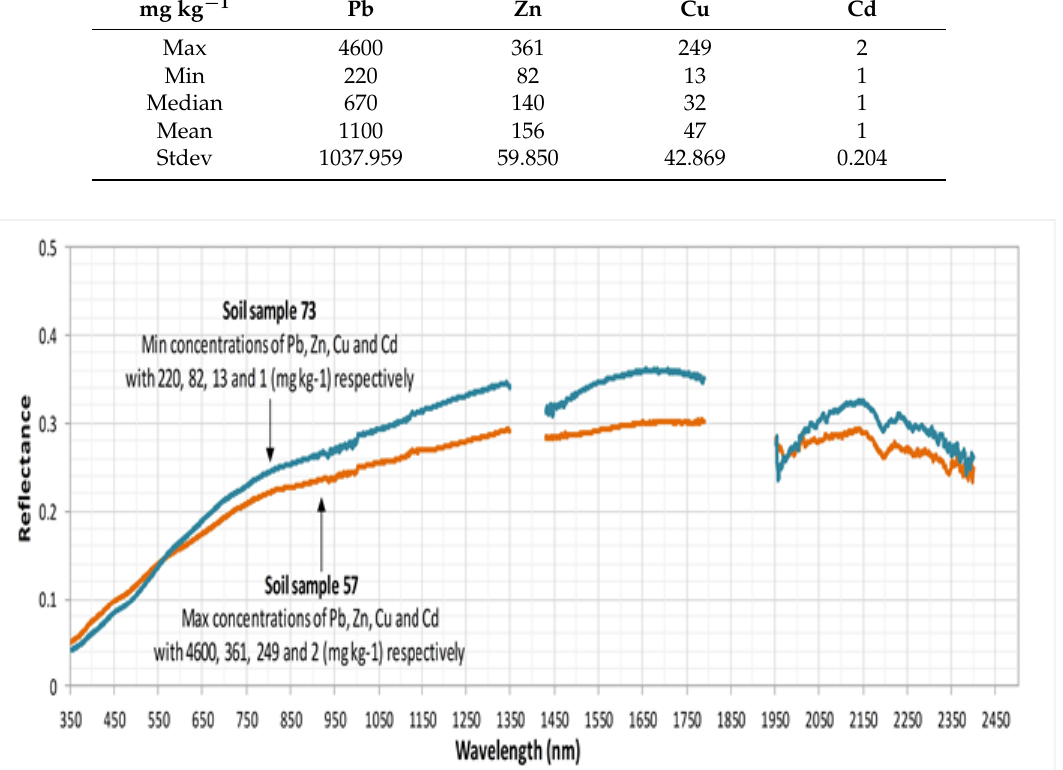
Figure 4. Mean spectra for soil samples characterised by low (sample 57) and high (sample 73) concentrations of heavy metals in the study site.